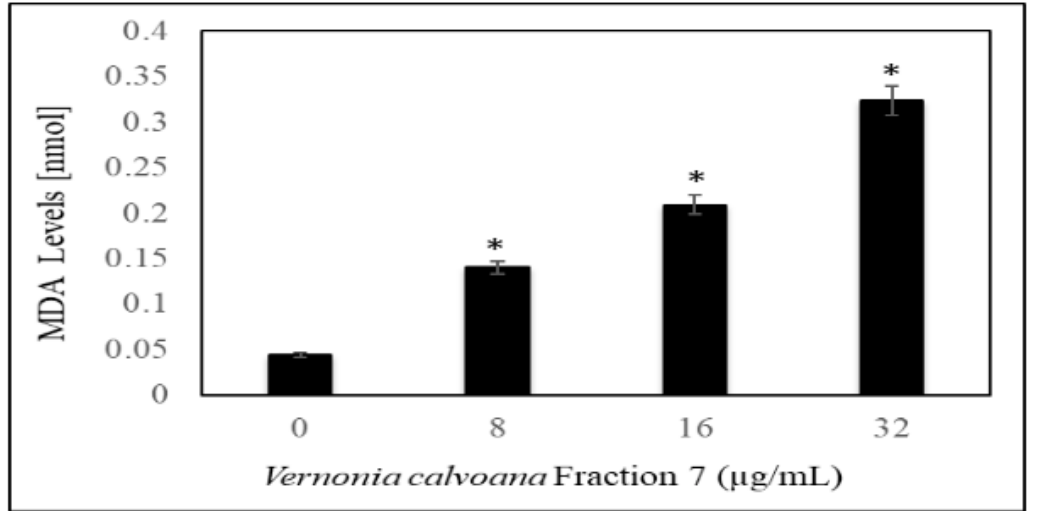
Figure 3. Effect of Vernonia calvoana fraction 7 (VC F7) on MDA production in untreated and treated OVCAR-3 cells for 48 hours. The doses that were found to be statistically significantly different ( p < 0.05) compared to the control are denoted by (*) according to ANOVA Dunnett.